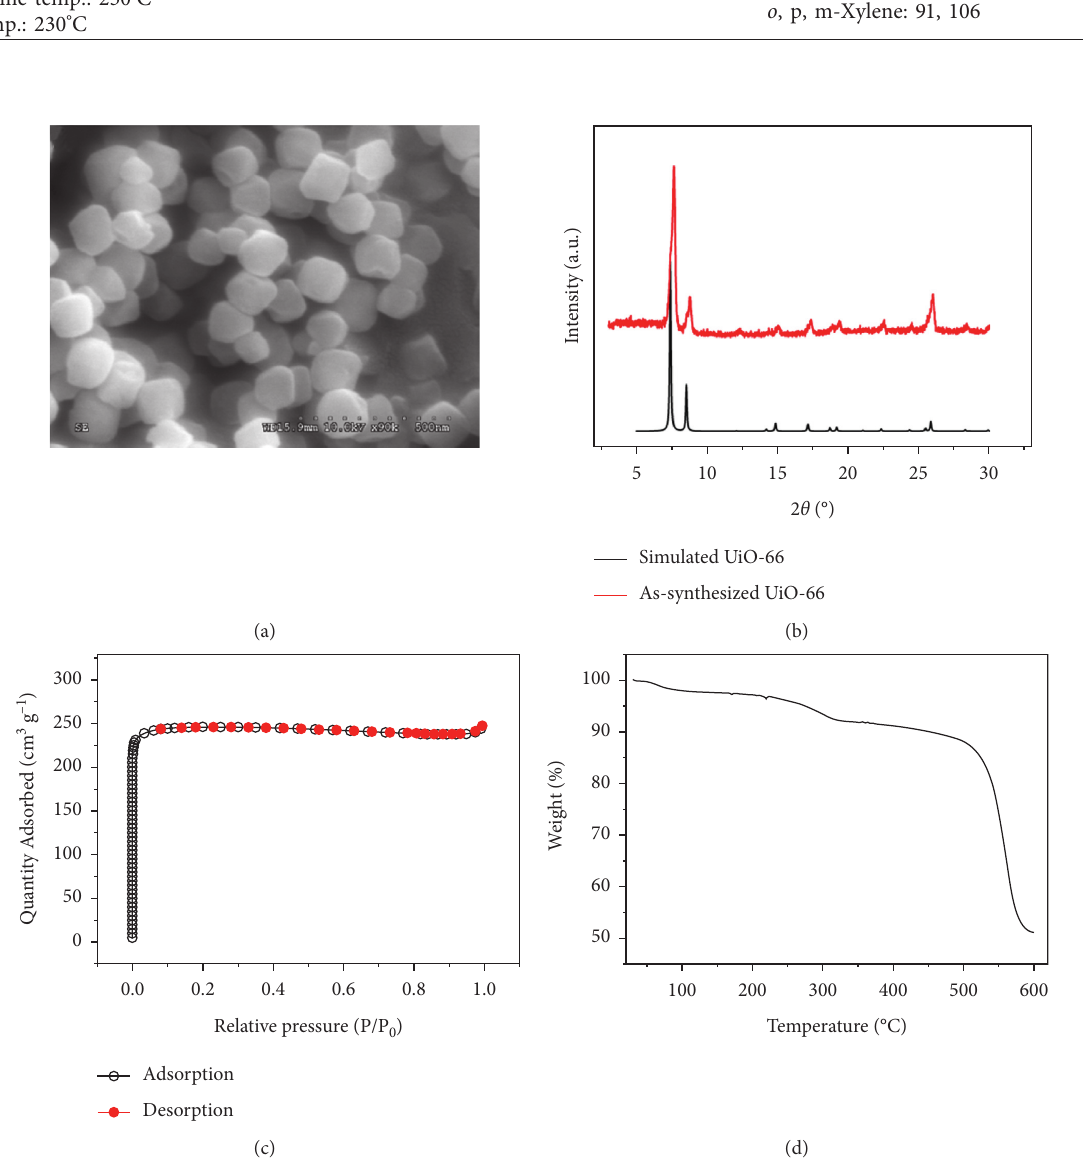
Figure 2: Characterization of UiO-66. (a) SEM image. (b) XRD patterns of simulated and as-synthesized UiO-66. (c) Nitrogen adsorption/ desorption isotherms. (d) TGA